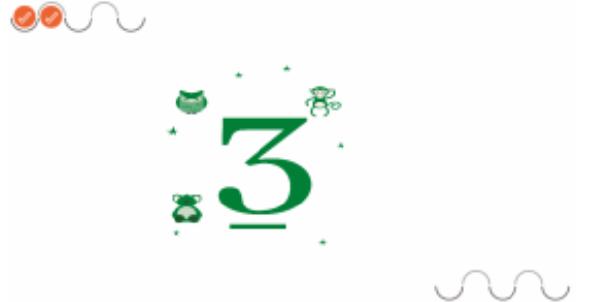
Figure 9. Interface of the game “What is the Card?”.